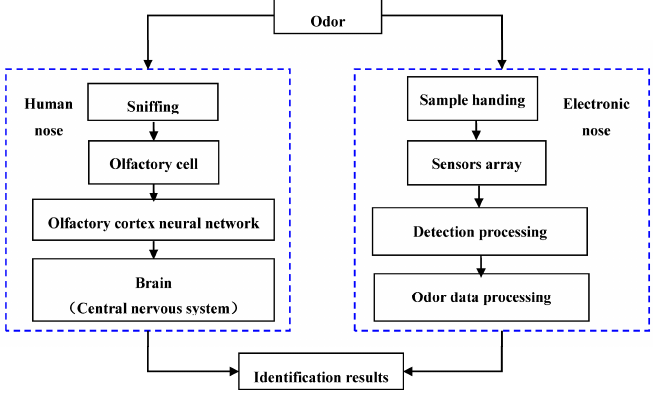
Figure 1. Comparison of human olfactory system and electronic nose.